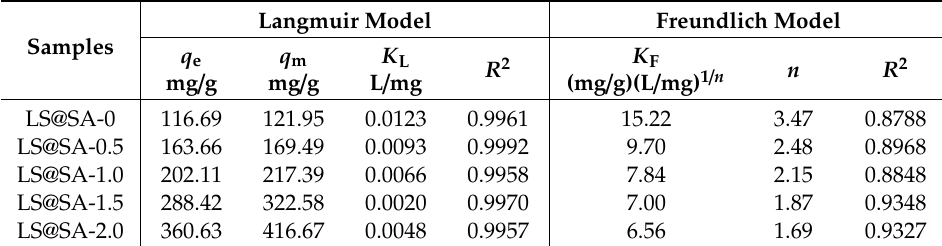
Table 2. Langmuir and Freundlich constants and correlation coe ffi cients associated with adsorption isotherms of MB onto LS@SA